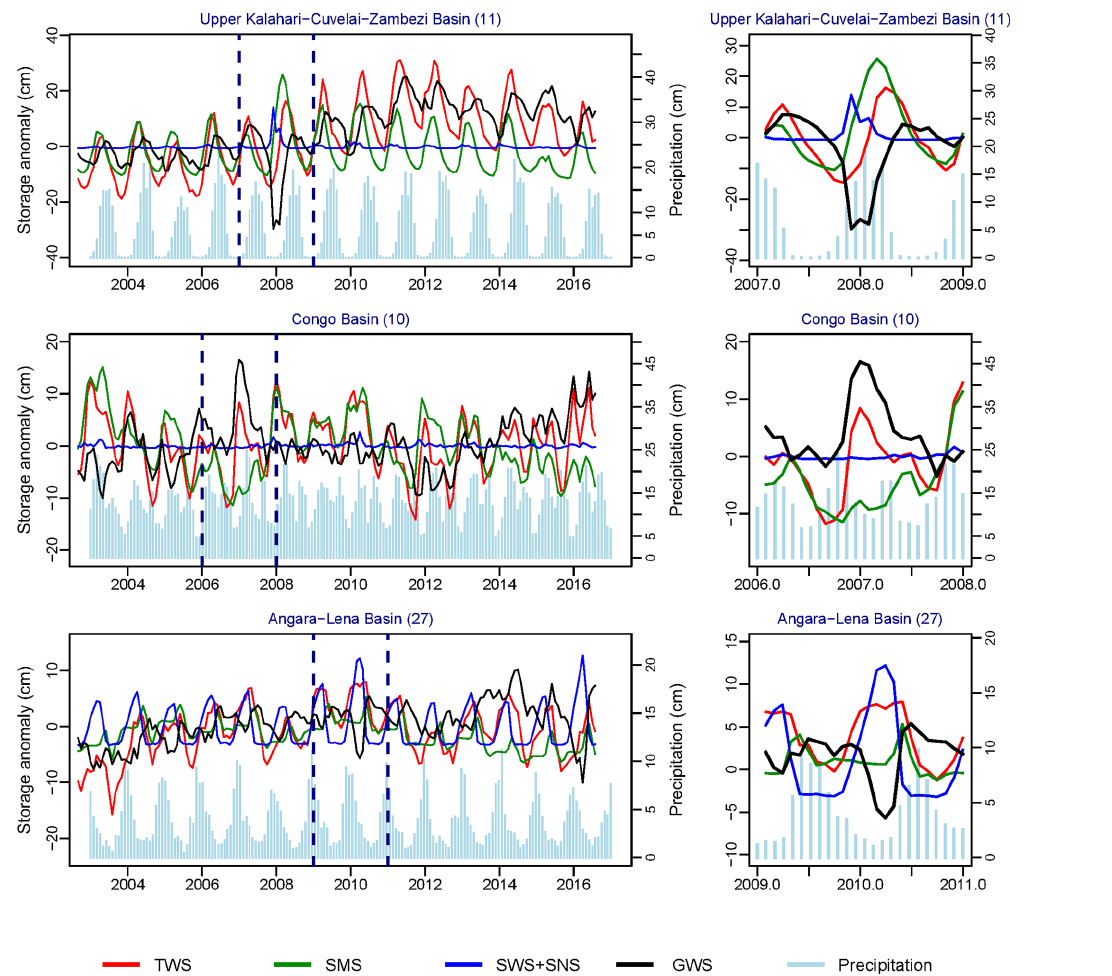
Figure 6. Time series of ensemble mean GRACE (cid:49) TWS (red), GLDAS (cid:49) SMS (green), (cid:49) SWS + (cid:49) SNS (blue), and computed GRACE (cid:49) GWS (black) showing the calculation of anomalously negative or positive values of GRACE (cid:49) GWS that deviate substantially from underlying trends. The three examples are (a) the Upper Kalahari–Cuvelai–Zambezi Basin (11) under a semi-arid climate, (b) the Congo Basin (10) under a tropical humid climate, and (c) the Angara–Lena Basin (27) under a temperate humid climate. Examples from an additional five aquifer systems under semi-arid and arid climates are given in the Supplement (Fig. S75).